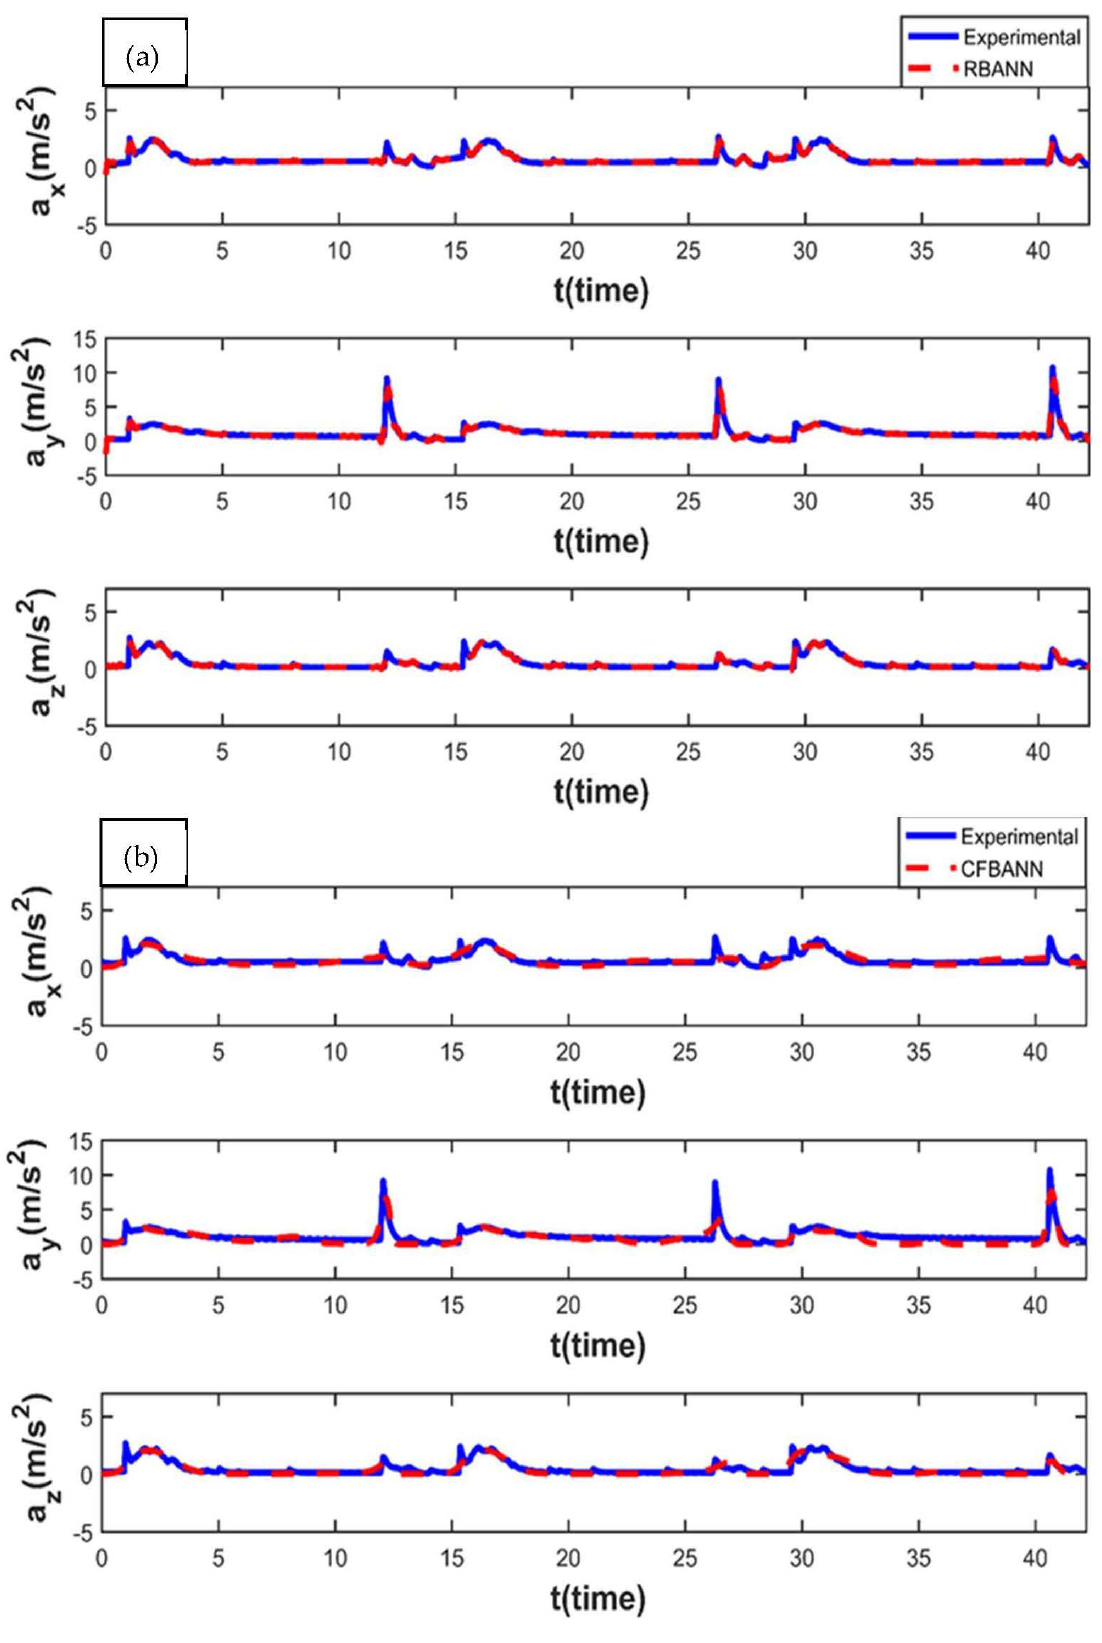
Figure 9. Experimental and ANN results obtained for the working condition of 11 s and 18.75 bar: ( a ) RBANN; ( b ) CFBANN.